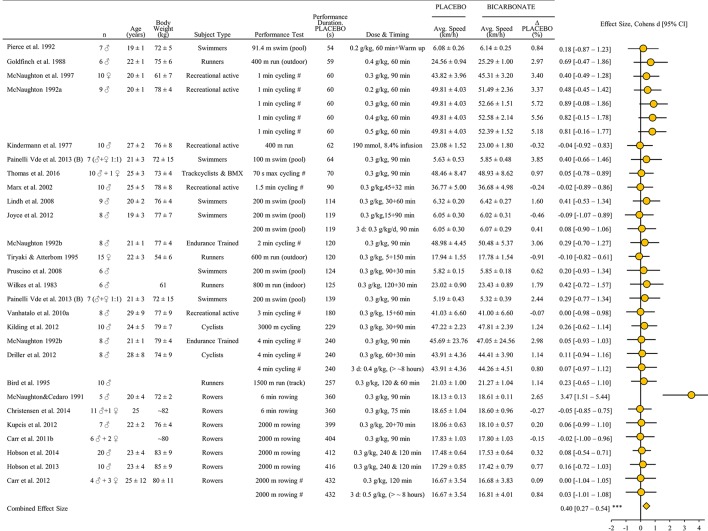
Standardized mean difference (effect size) with 95% confidence intervals as reported in studies of bicarbonate supplementations impact on performance (average speed) relative to placebo in athletic endurance events lasting 45 s to 8 min. The combined effect size has been calculated as described in methods section. All other data is reported as mean ± SD. All performance tests were executed indoors on ergometers or treadmills unless stated differently. Regarding Dose & Timing: Dose is listed as gram pr kilo bodyweight (g/kg) and “60 min” denotes time from ingestion to start of test. “30 + 60 min” denotes a 30 min period to consume capsules followed by additional 60 min before start of test and “240 & 120 min” denotes intake of capsules 240 and 120 min before start of test. For studies with chronic loading the amount of days (d) is listed as well as timing of last dose before performance test. #Speed estimated from mean power reported. ***Significant effect of bicarbonate on performance (P < 0.001).